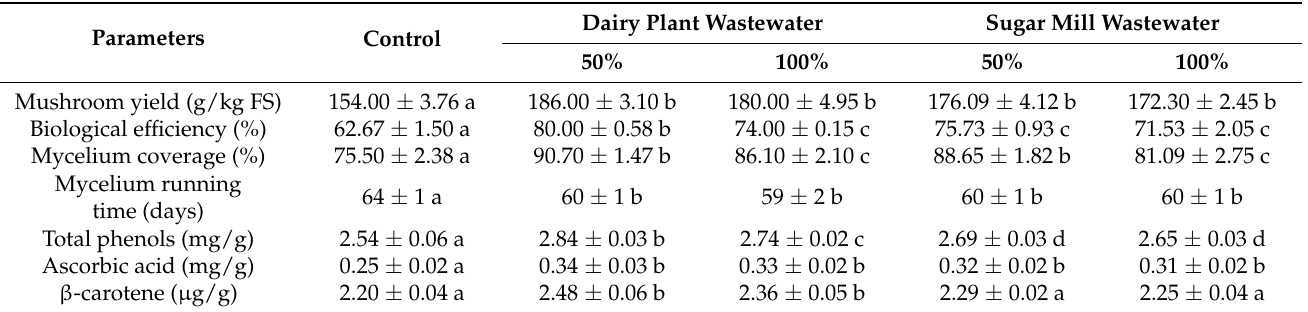
Table 3. Effect of agro-industrial wastewaters on yield and biochemical properties of cultivated Shiitake ( L. edodes )